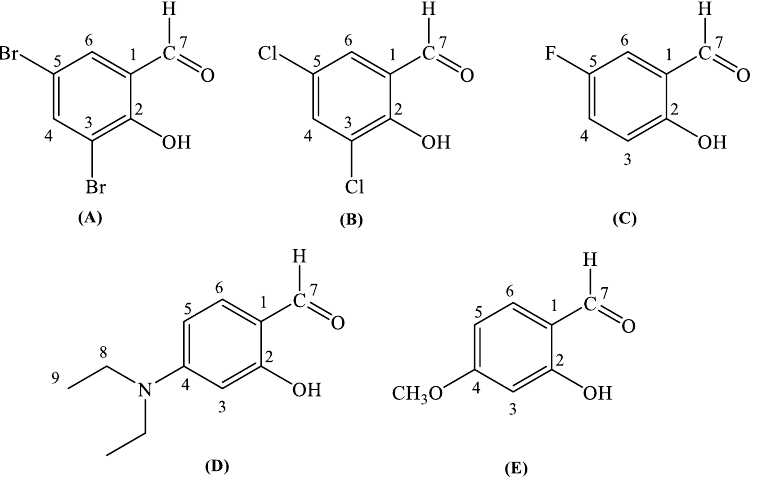
Figure 1. Syntax formula and H-atom numbering for ( A ) 3,5-diBr-saloH, ( B ) 3,5-diCl-saloH, ( C ) 5-F-saloH, ( D ) 4-Et 2 N-saloH, and ( E ) 4-OMe-saloH.